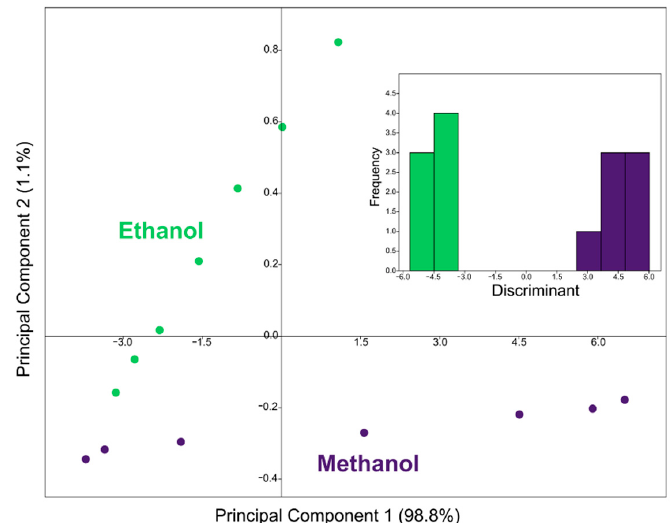
Figure 3. Plot of the first two main components illustrating the measurements at different concentrations (1 to 100 ppm) of ethanol (in green) and methanol (in violet). Inset: Linear discriminant analysis of the points relating to the two gases, which shows how they are separated and distinguishable.